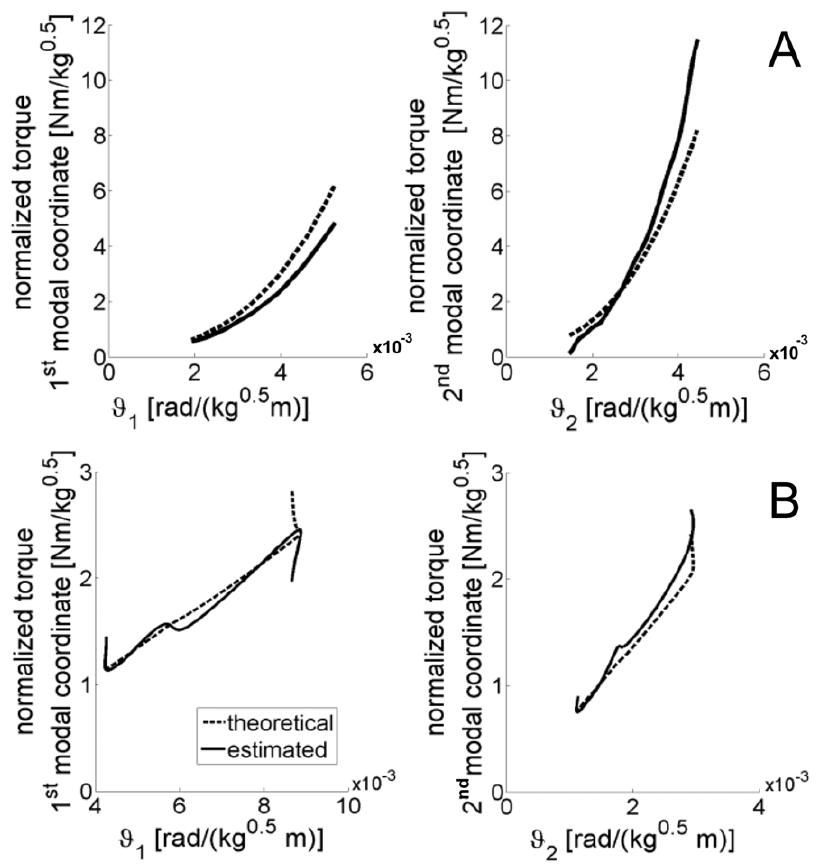
Figure 12. Estimation of normalized force for non-linear and higher-order systems. A) Estimation of normalized force for the Duffing model for 2 DOF. Solid line represents estimation, while dashed line depicts the imposed value. B) Estimation of normalized force for the Poynting- Thomson model.